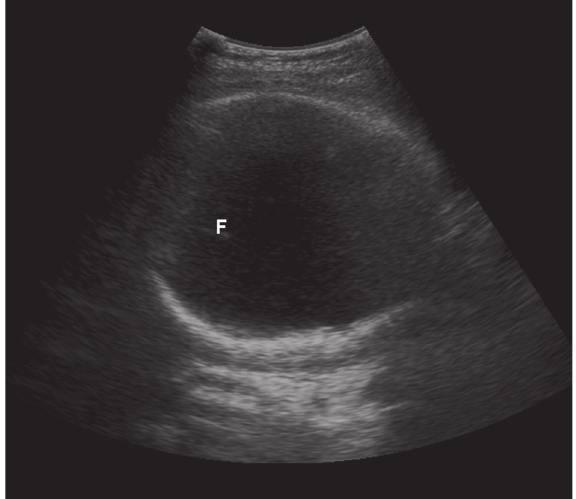
Figure 2. Prenatal ultrasound scans image of the fetus. Transabdominal transverse section of the fetal head shows disrupted falx